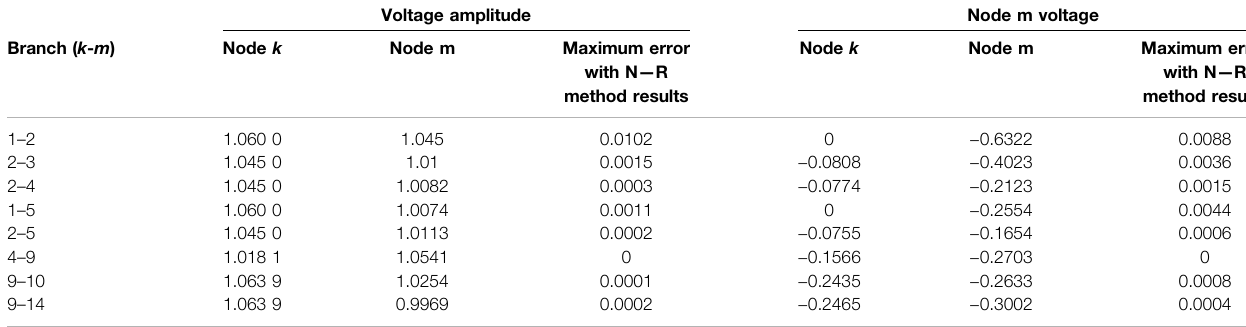
TABLE 4 | Calculation results of branch breaking power fl ow of the Newton – Raphson method and comparison with the proposed